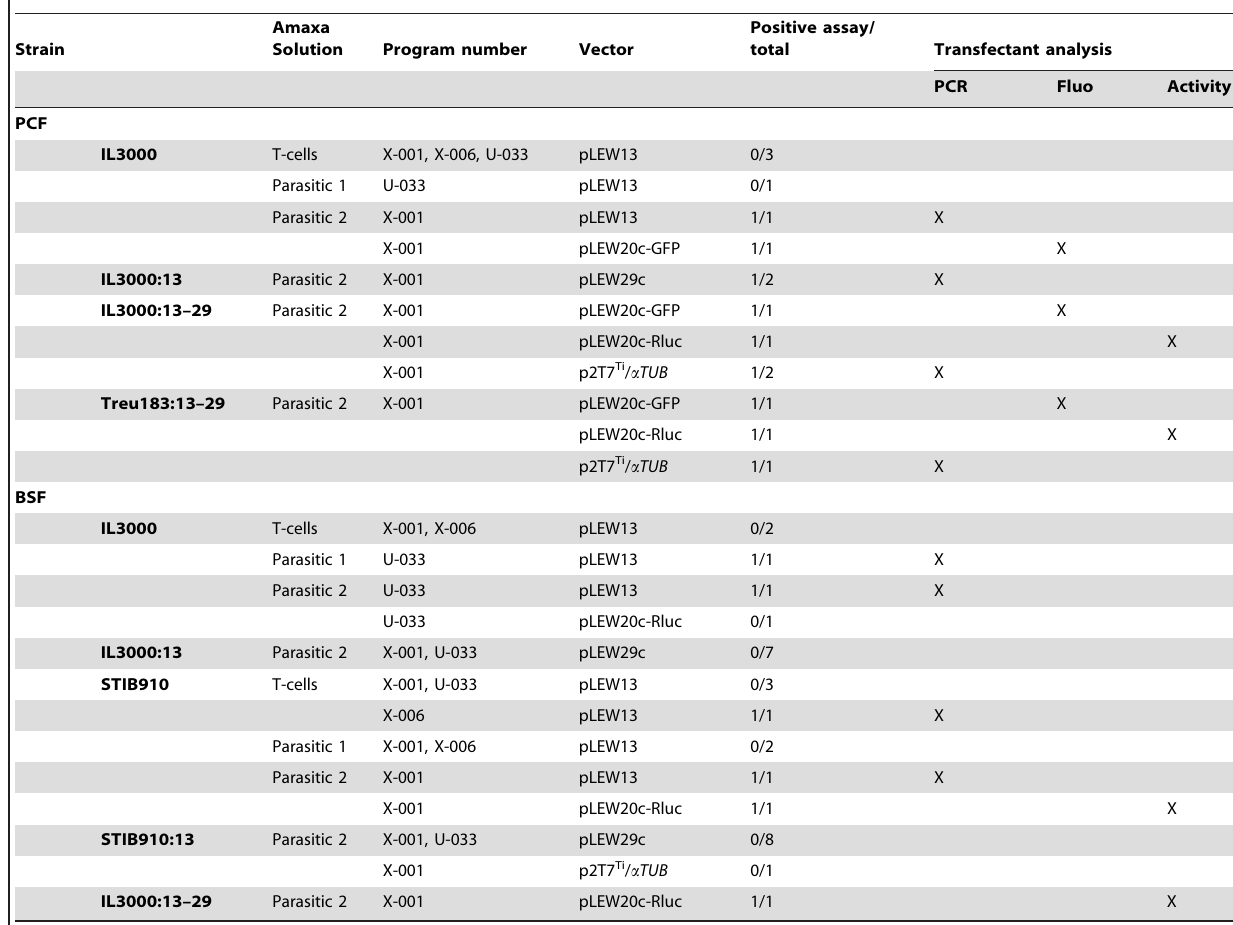
Table 2. Amaxa nucleofection